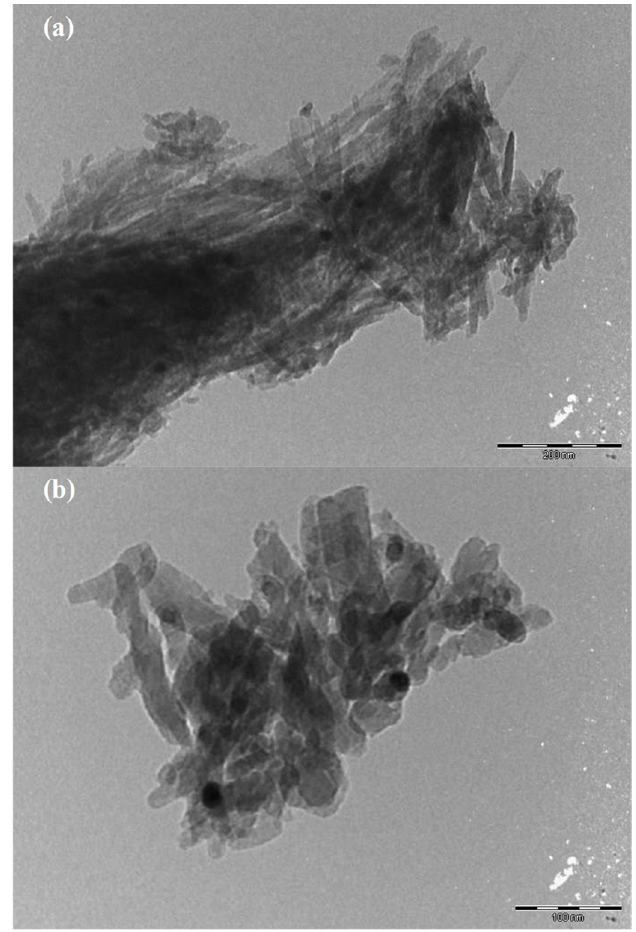
Figure 8. TEM images of 25 ppm AuNPs loaded onto natural sepiolite samples: 200 nm scaled ( a ) and 100 nm scaled ( b ), respectively.